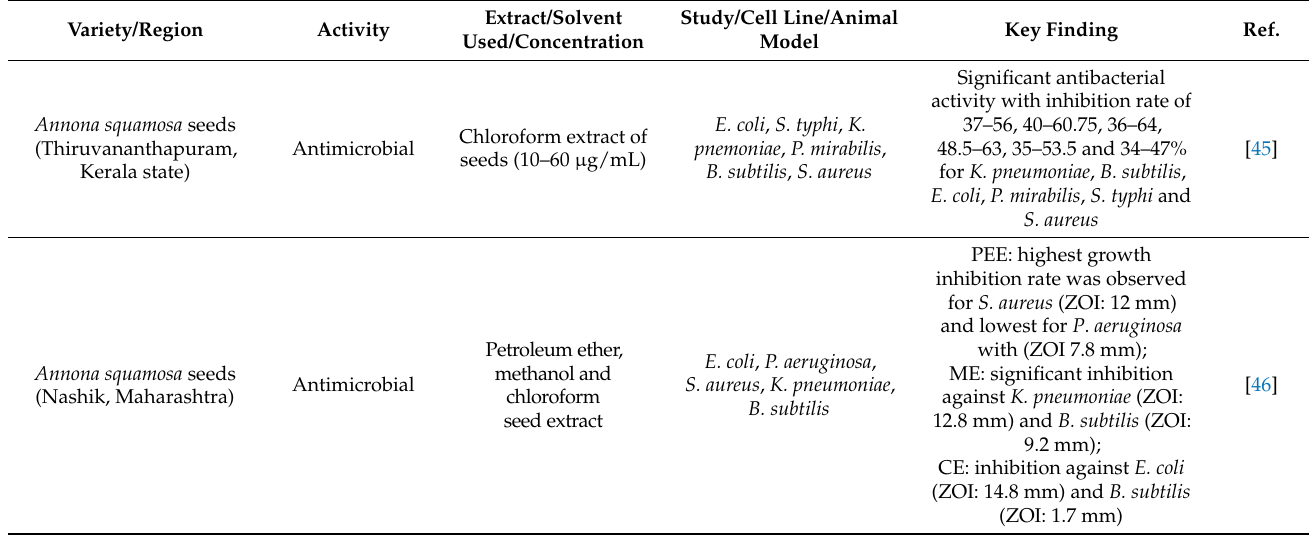
Table 2. Pharmacological properties of Annona squamosa seeds.